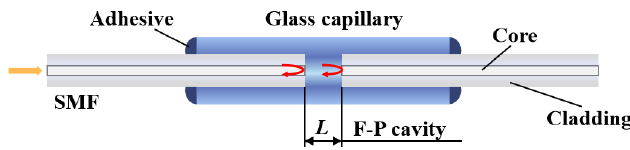
Figure 1. Schematic diagram of a typical fiber-optic F–P sensor.